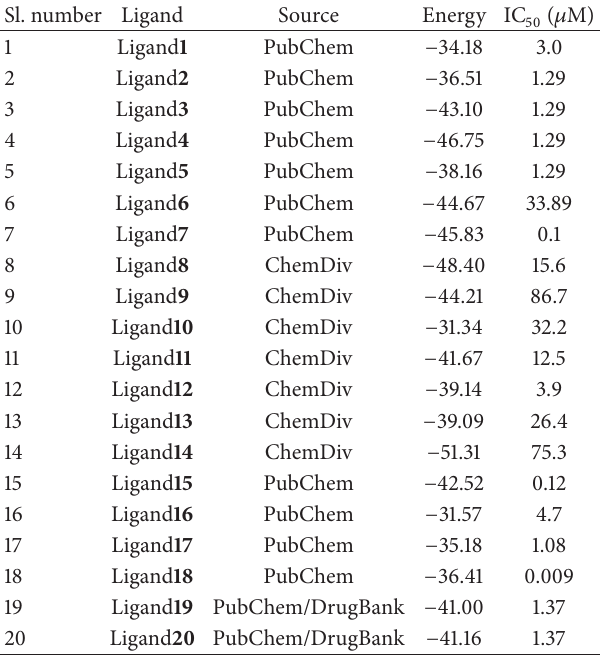
Table 1: GLIDE-XP energies (kcal/mol) of selected 20 ligands with IC 50 values.